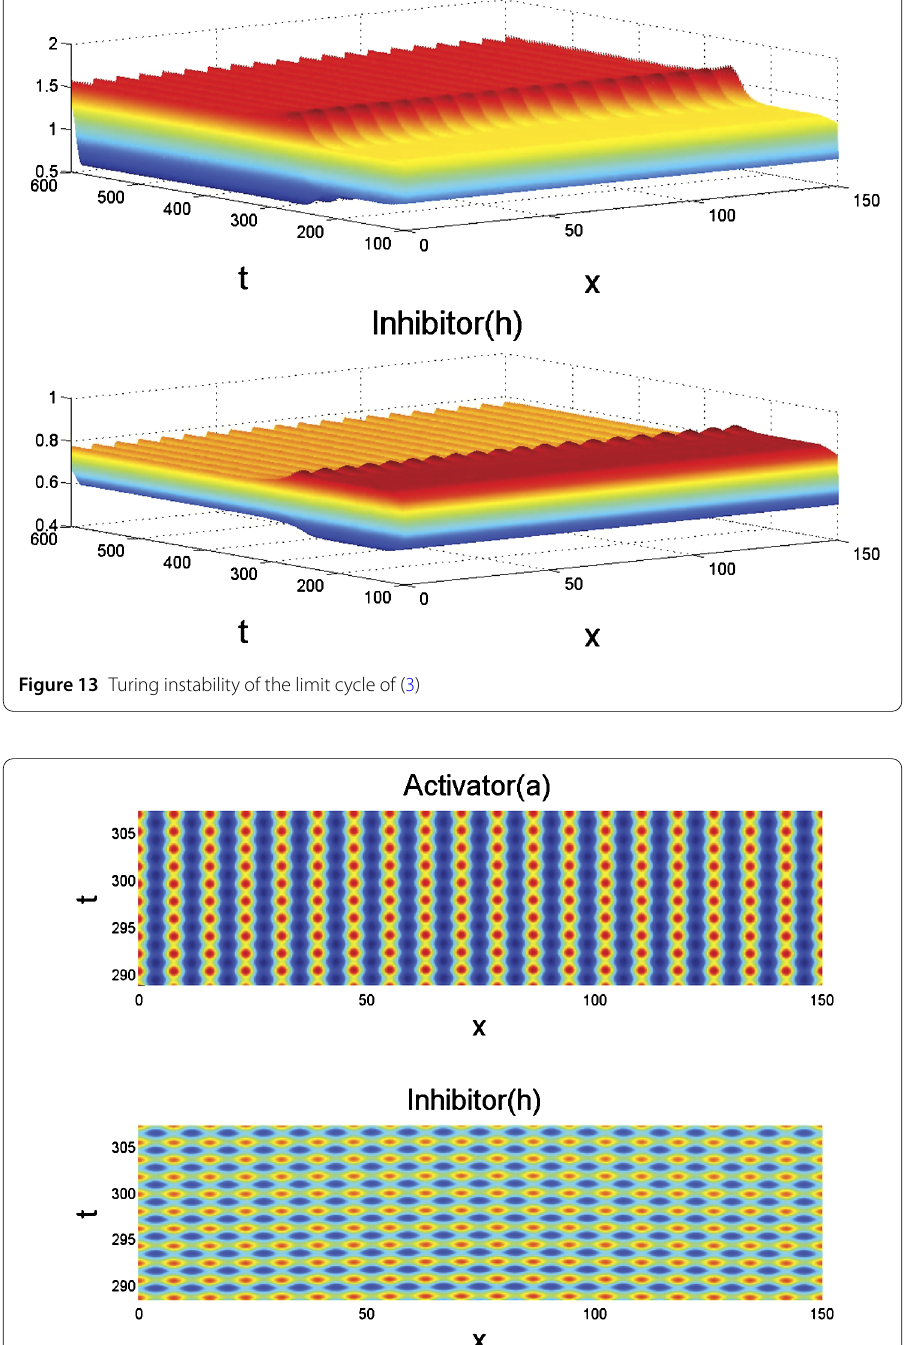
is the region in which the equilibrium may undergo Turing bifurcation. The regions be- low the line c = c h are also divided into two parts. In the orange region, no Turing patterns will occur. It is the region where the equilibrium is unstable and bifurcates a stable